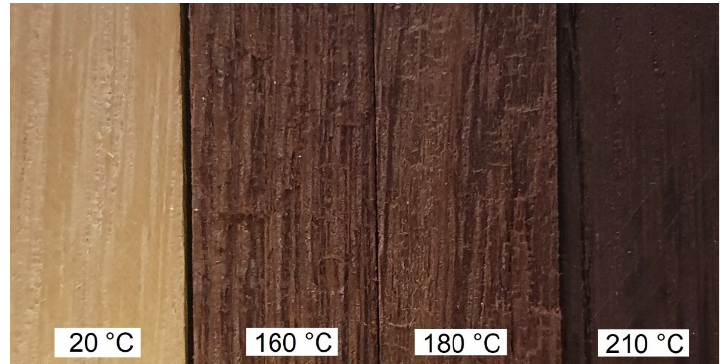
Figure 1. Samples of the original and thermally modified black locust wood. Table 2. The averages of black locust colour properties in CIE L * a * b * colour space (mean ± SD). Temperature L * a * b * ∆ E 20 ◦ C 69.5 ± 1.96